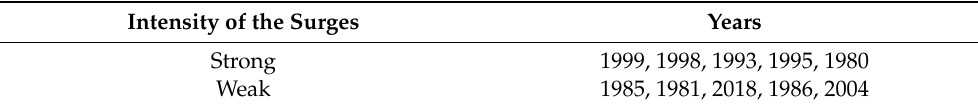
Table 2. Years with strong and weak East Asian subtropical monsoon surges.